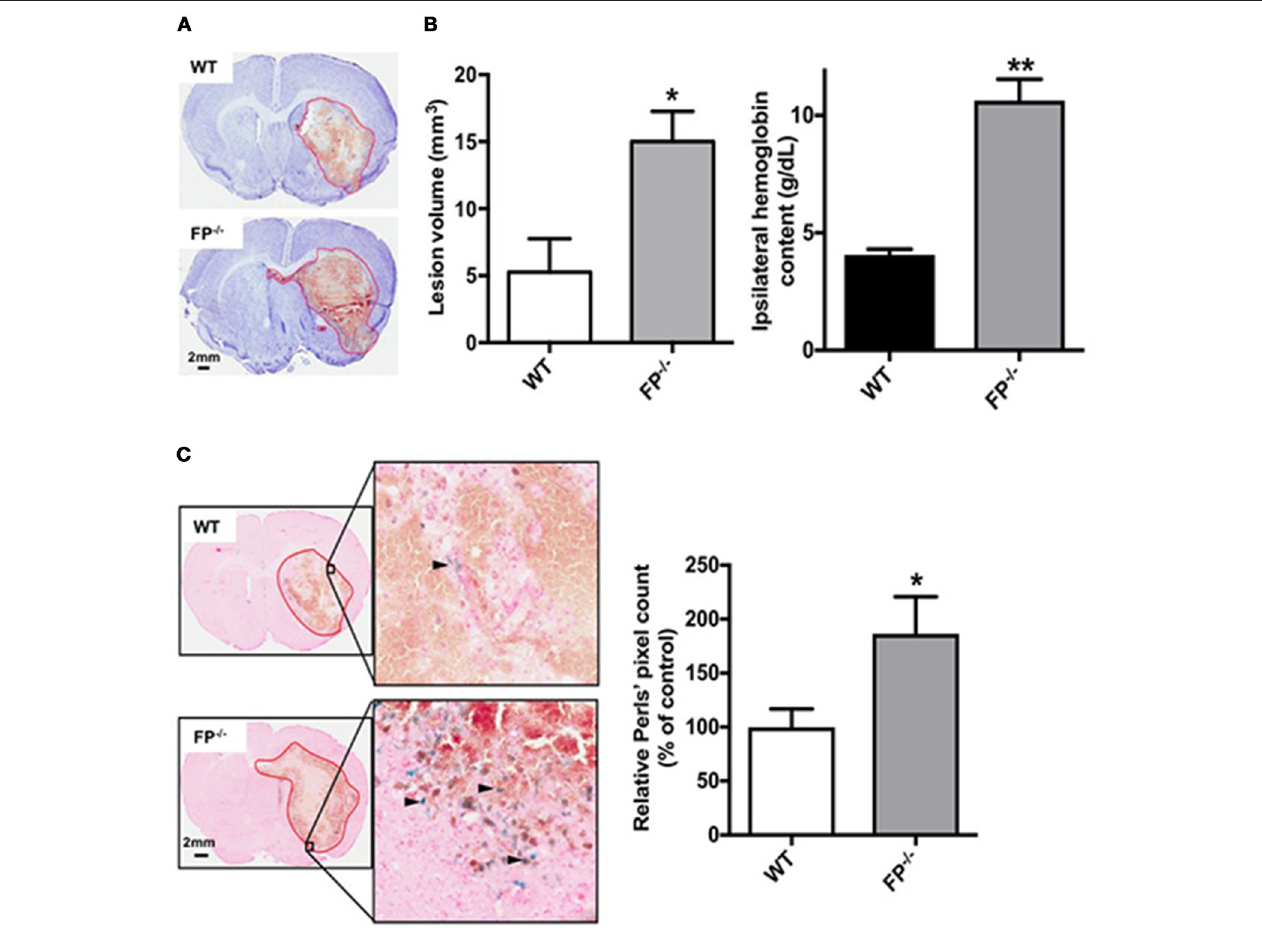
FIGURE 2 | Genetic deletion of the PGF 2 α -FP receptor increases brain injury after ICH. WT and FP − / − mice underwent ICH and were euthanized at 72h for determination of lesion volume by Cresyl violet staining of brain sections. (A) Representative images of coronal brain sections from WT (upper panel) and FP − / − mice (lower panel) show FP − / − mice as having a greater lesion volume. Images were obtained from a single animal and demonstrate the characteristic hematoma profile for WT and FP − / − mice, captured adjacent to the needle insertion site and representing maximal hematoma size. Quantification of lesion volumes showed that FP − / − mice had significantly greater ICH-induced brain injury. (WT: n = 7, FP − / − : n = 10, * P < 0.05). (B) In a separate cohort, quantification of hemoglobin content volumes at 72h showed that FP − / − mice had significantly greater ICH-induced hemoglobin content compared to WT mice (WT: n = 3, FP − / − : n = 3, ** P < 0.01). (C) Genetic deletion of the FP receptor increased brain ferric iron content, as represented by Perls staining post-ICH. Representative high magnification images of coronal brain sections show Perls staining (blue) in peri-hematomal regions in WT (upper panel) and FP − / − mice (lower panel). Square selections in the inserts denote magnified regions. Quantification of blue positive pixel count in the ipsilateral hemisphere showed that FP − / − mice had significantly greater ferric iron deposition (WT: n = 6, FP − / − : n = 6, * P <